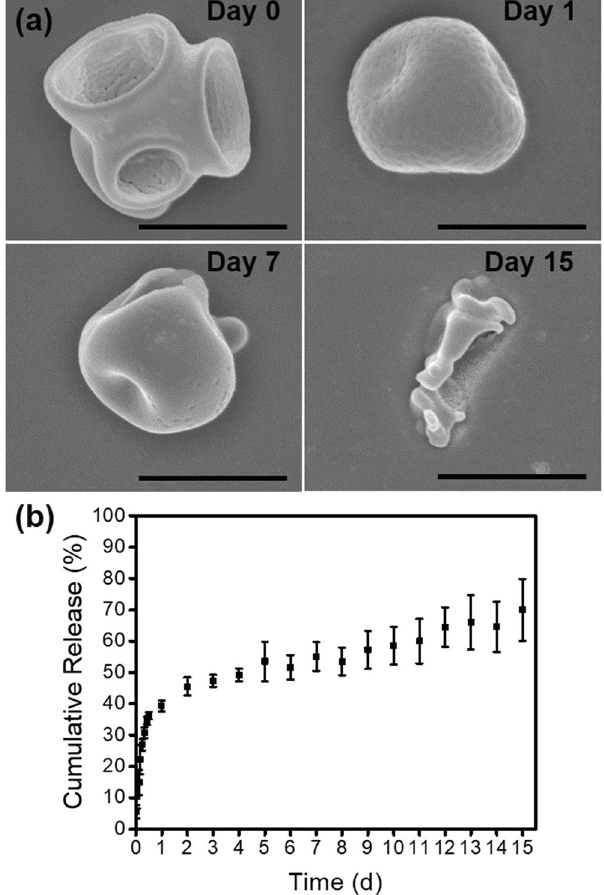
Figure 4. ( a ) SEM image of RhB-mcPLGAs incubated in PBS at 37 °C across 15 days. The scale bars represent 1 μ m. ( b ) Release profile of model drug (RhB) from RhB-mcPLGAs MPs. The bars represent the standard deviation for 5 independent